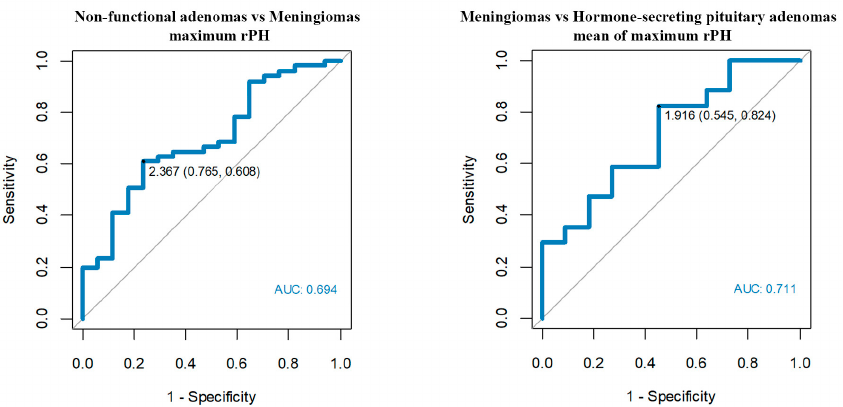
Figure 6. Optimum rPH cut-off points among meningiomas, non-functional pituitary adenomas and hormone-secreting adenomas. - Maximum rPH`3 > 2.37 enables us to di ff erentiate meningiomas from non-functional